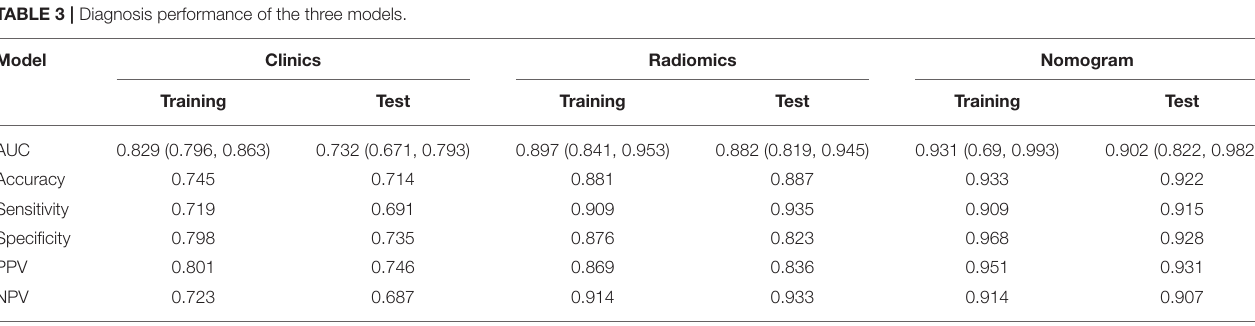
Data are percentages with 95% CIs in square parentheses. Nomogram indicates the integrated model combining of clinics and radiomics features; PPV, positive predictive value; NPV, negative predictive value.